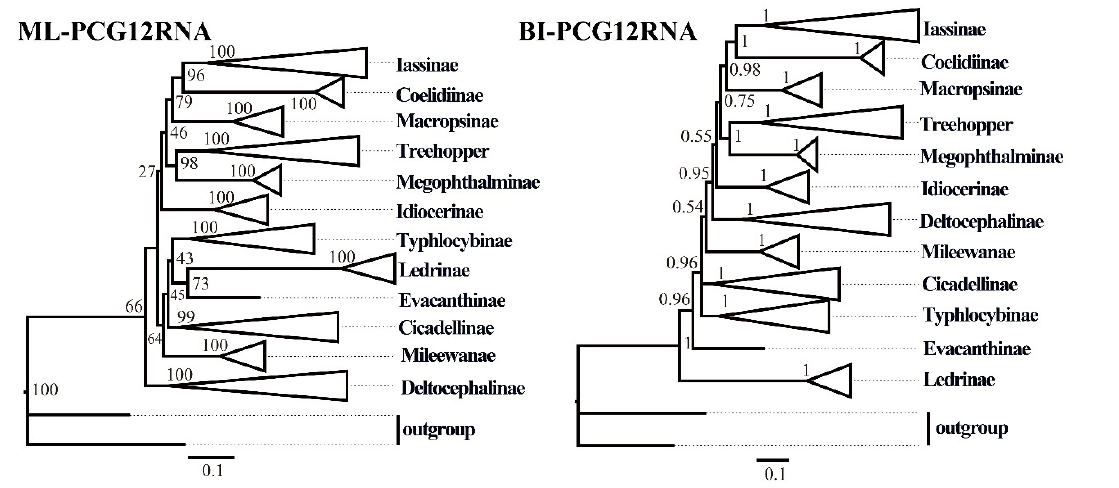
Figure 7. The phylogenetic trees of leafhoppers were inferred from different mitochondrial genome datasets using maximum likelihood (ML) and Bayesian inference (BI) methods. AA: amino acid sequences of the protein-coding genes (PCGs) from 73 species; PCG12: first and second codon positions of PCGs from 73 species; PCG12RNA: the first and the second codon positions of the PCGs and two rRNA genes from 67 species. Numbers on each node correspond to the bootstrap support values (BS) and Bayesian posterior probability (PP).